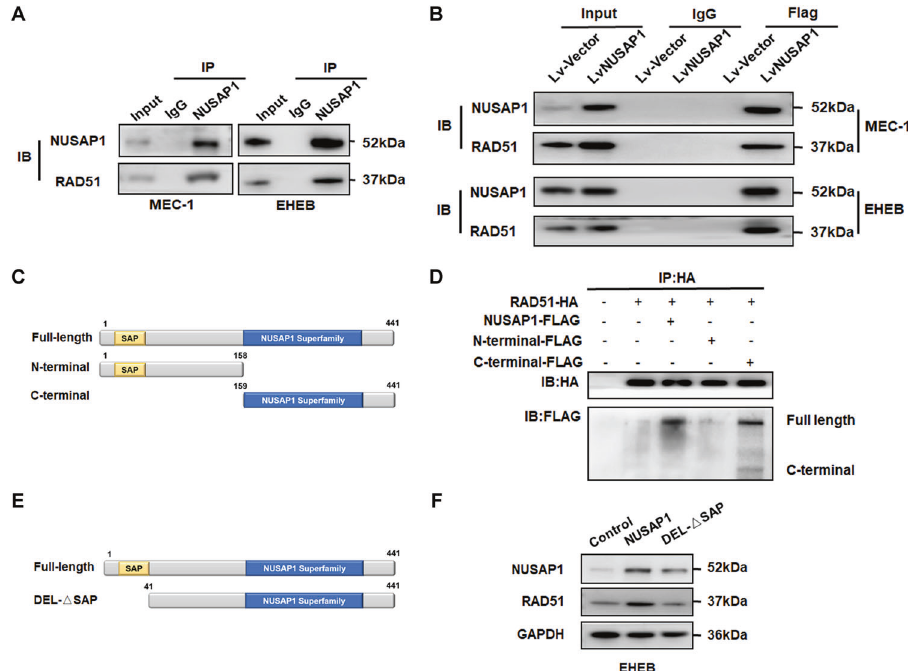
Fig. 5 NUSAP1 bound with RAD51 via the C-terminus. A Endogenous interaction of NUSAP1 with RAD51 veri fi cation by Co-IP. B Exogenous interaction of NUSAP1 with RAD51 veri fi cation by Co-IP. C Structural representation of main domains of NUSAP1. D Interaction of RAD51 with truncated NUSAP1 in EHEB cells. E The SAP domain on the N-terminus of NUSAP1. F The protein expression levels of RAD51 while upregulating NUSAP1 and NUSAP1- Δ SAP in EHEB